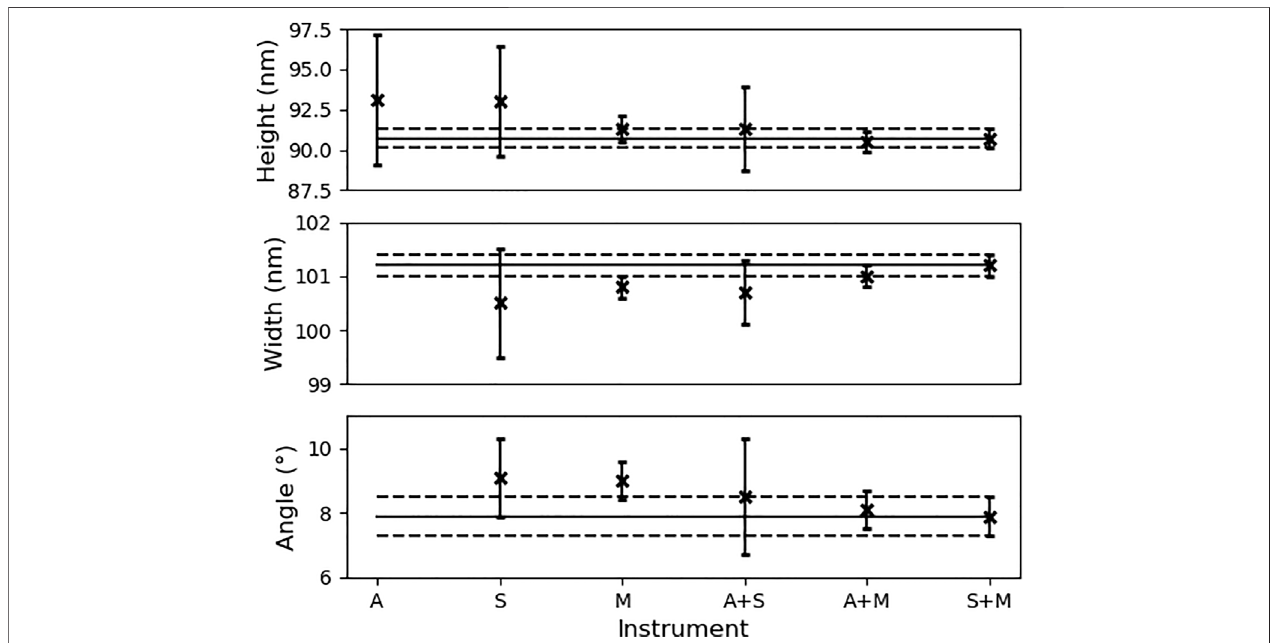
FIGURE 7 | Measurement results for the patterned silicon structure, Γ x (cid:1) Γ y (cid:1) 200 nm, with uncertainties. The fully drawn line corresponds to the result found by combining all instruments, and the dashed lines denote the upper and lower boundary de fi ned by the uncertainties. The uncertainties shown are the 2 σ taken at 95% con fi dencelevel.WeusetheabbreviationsAforAFM,Sforscatterometry,andMforMuellerellipsometryinthe fi gure.Thecornerroundingsandtheoxidelayerhasbeen locked to R top (cid:1) R bot (cid:1) 5 nm and d (cid:1) 2 nm. AFM was only used for height measurement of the structures. The shown values are tabulated in Supplementary Table S1 .